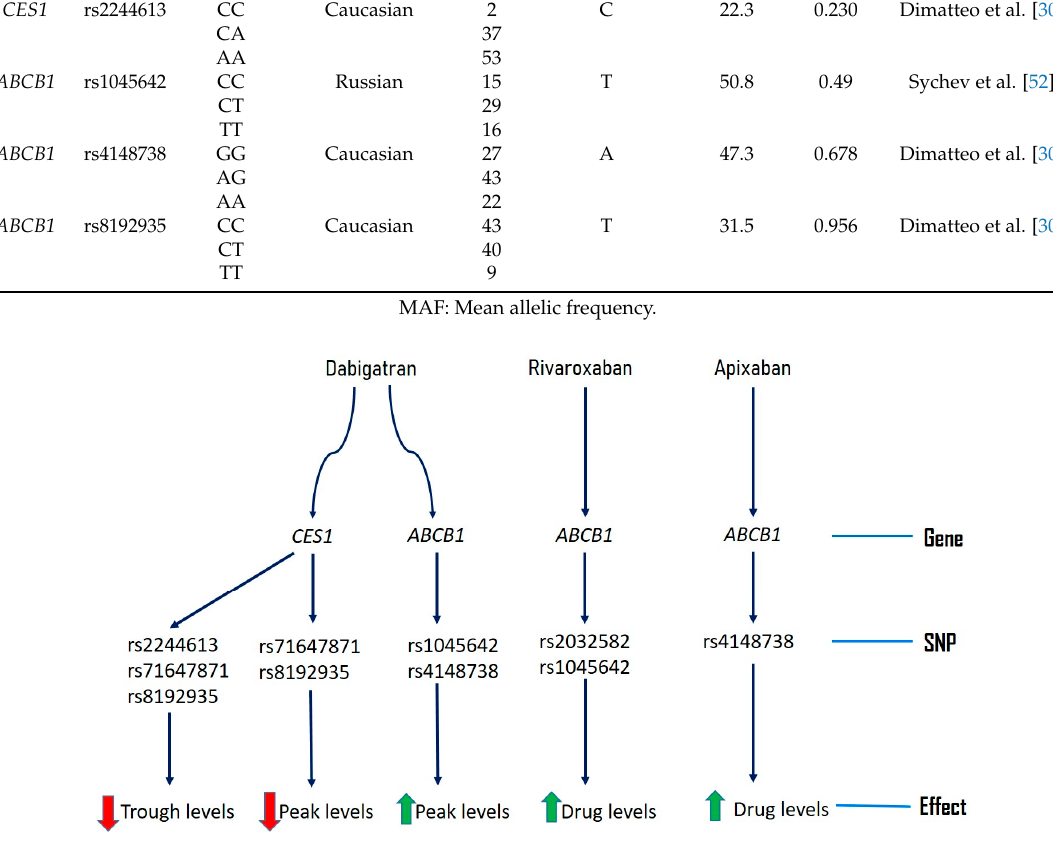
Figure 1. Pharmacogenomics of novel direct oral anticoagulants.